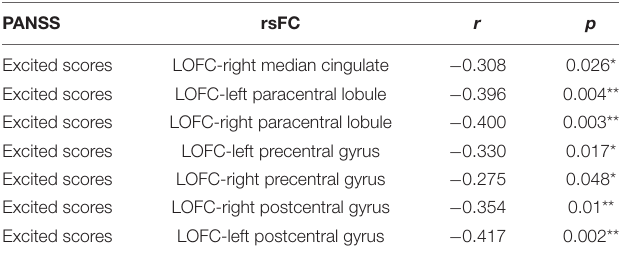
TABLE 5 | Correlations between the rsFC values and PANSS excited scores in patients with FES (taking age, gender, education, and illness duration into covariates).